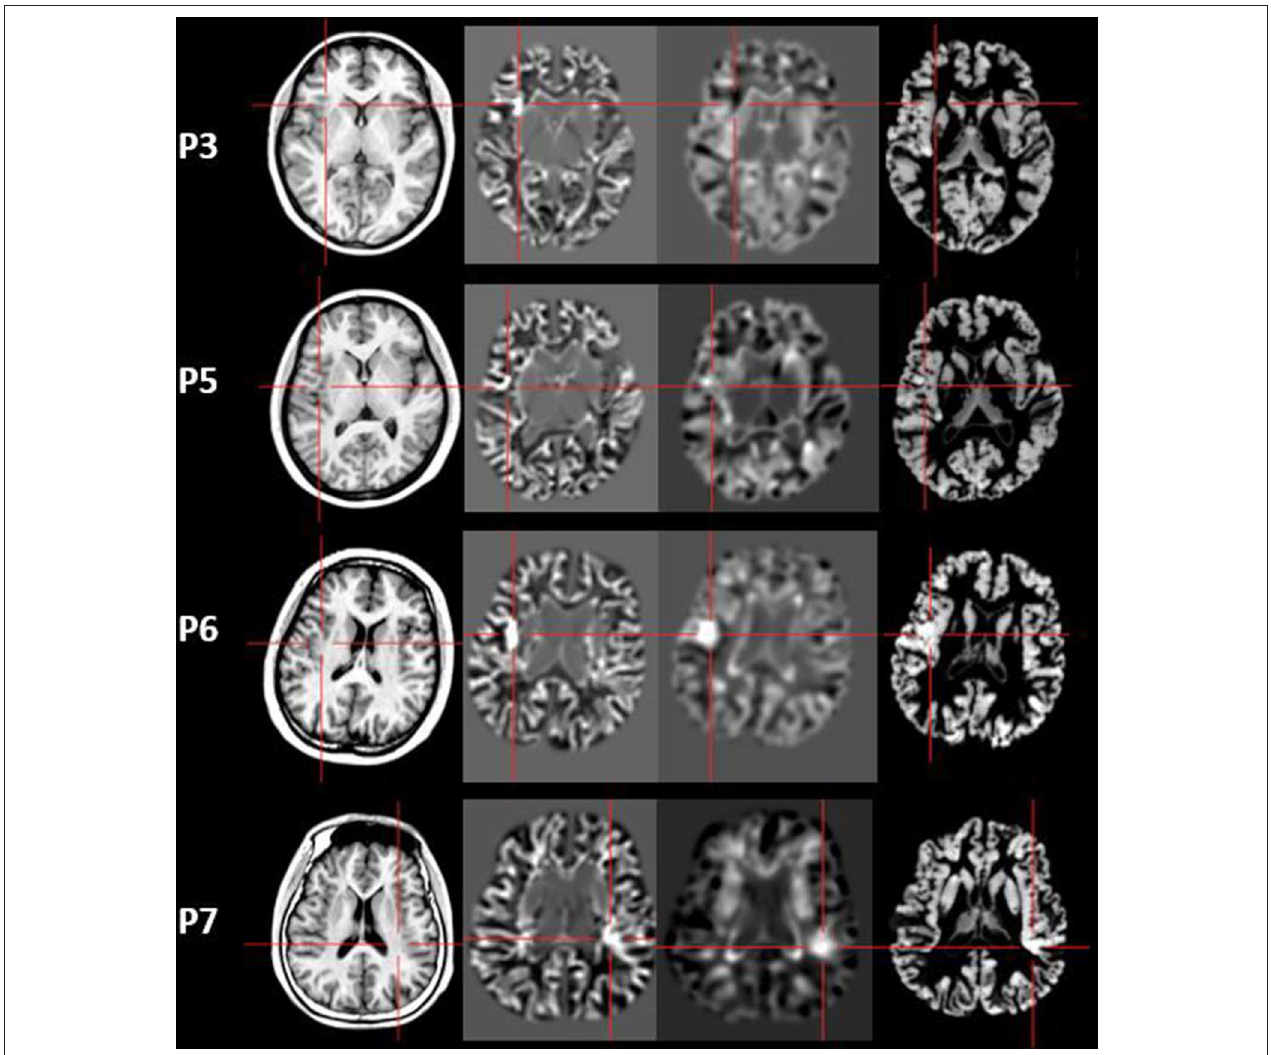
FIGURE 5 | The junction z-score images, extension z-score images, and thickness z-score images of MAP-positive patients (Patient 3, 5, 6, and 7). First column: T1-weighted magnetization prepared rapid acquisition with gradient echo (MPRAGE) images used as input to MAP. Second column: junction z-score image of MAP. Third column: extension z-score image of MAP. Fourth column: thickness z-score image of MAP. All of the four patients had positive results on junction z-score images. However, only two patients (P6 and P7) showed positive results on extension z-score images and thickness z-score